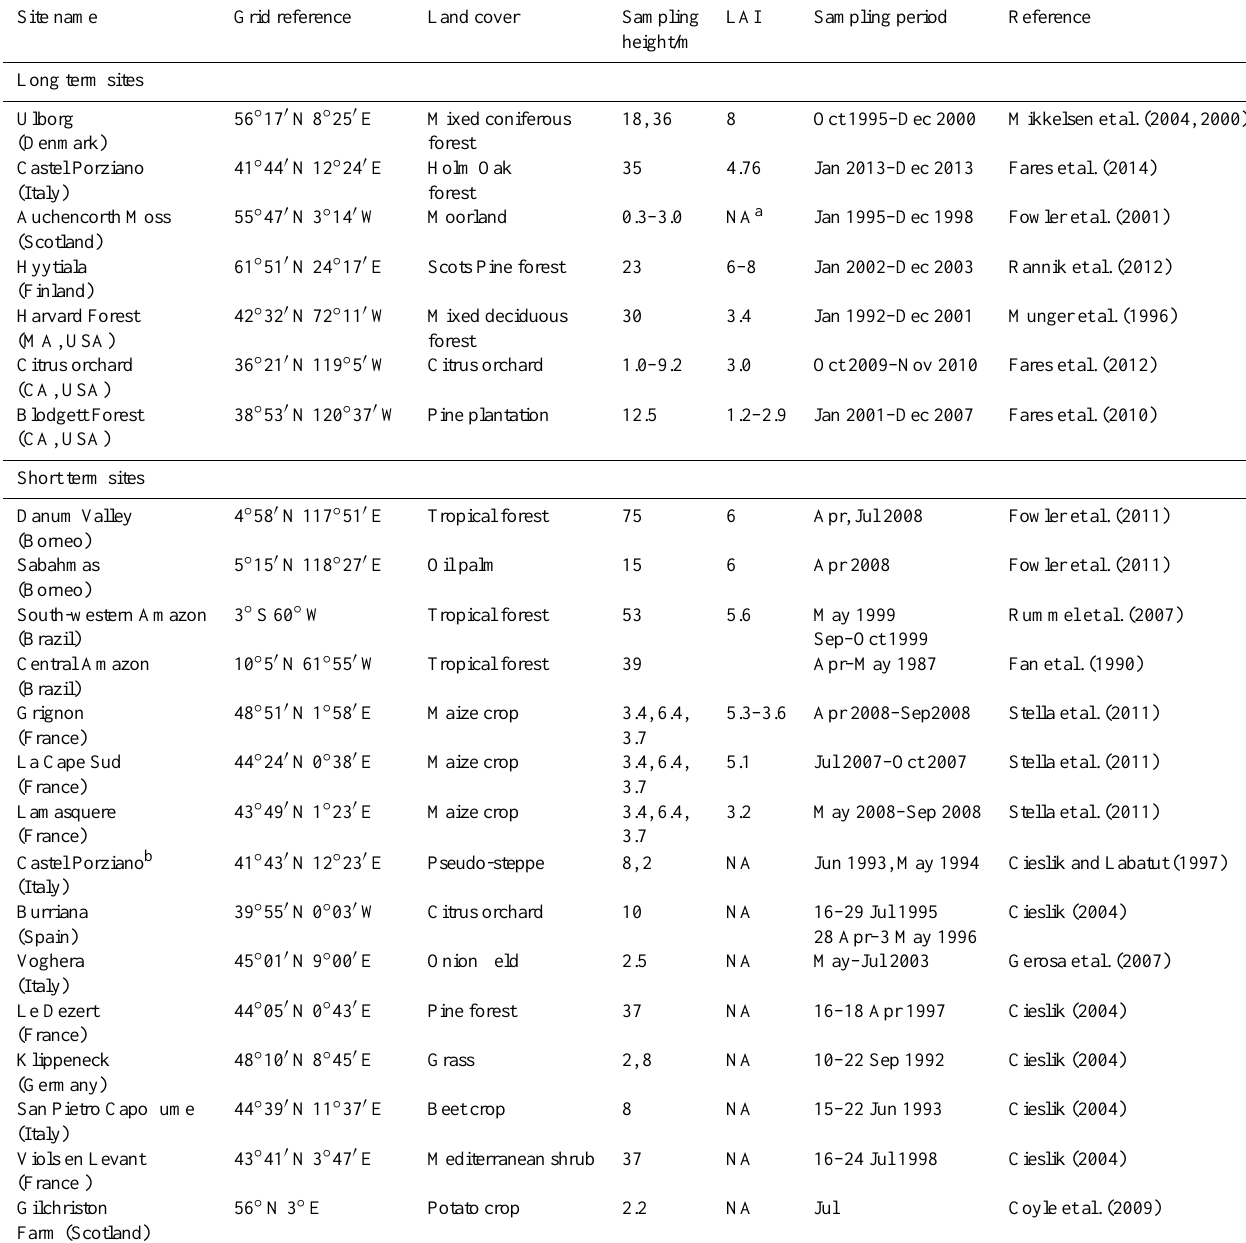
Table 3. O 3 dry deposition measurement